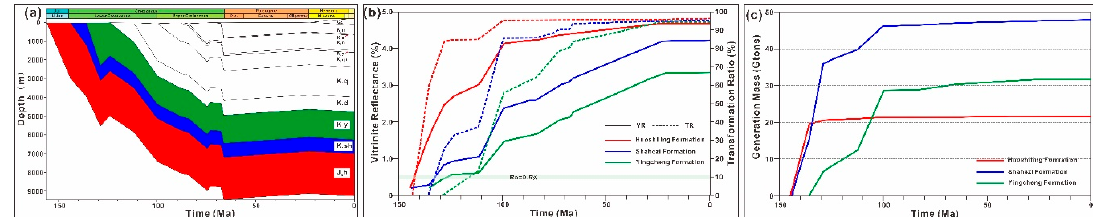
Figure 14. Burial history, maturity evolution and hydrocarbon-generation mass of the main source rocks in the Changling Depression. ( a ) Burial history of the three main source rocks: Yingcheng (red), Shahezi (blue) and Huoshiling (green) Formations. ( b ) Evolution of the VR and TR throughout geological time (pseudo well location: X: 21568.264 km, Y: 4927.123 km). ( c ) Amount (in mass) of hydrocarbons that were generated from the three main source rocks over time (from the entire study area).